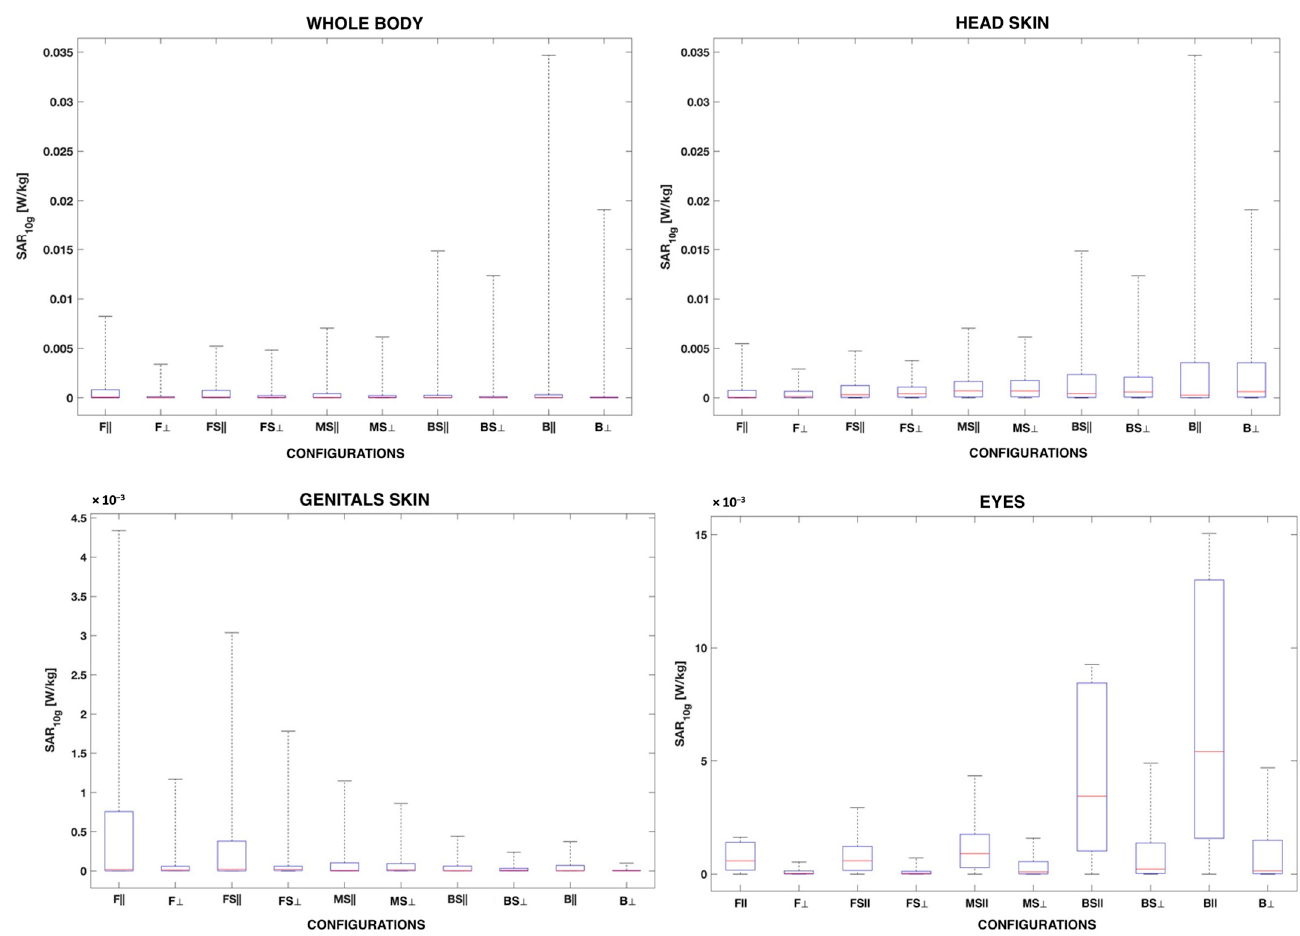
Figure 6. Box plot of the SAR 10g distribution in the skin of the whole body, head, and genitals and the eye tissues as a function of the human model configuration. The red mark in the center of the box indicates the median; the bottom and the top edges of the box indicate the 25th and 75th percentiles, respectively. The upper and lower whiskers represent the maximum and minimum SAR 10g values.